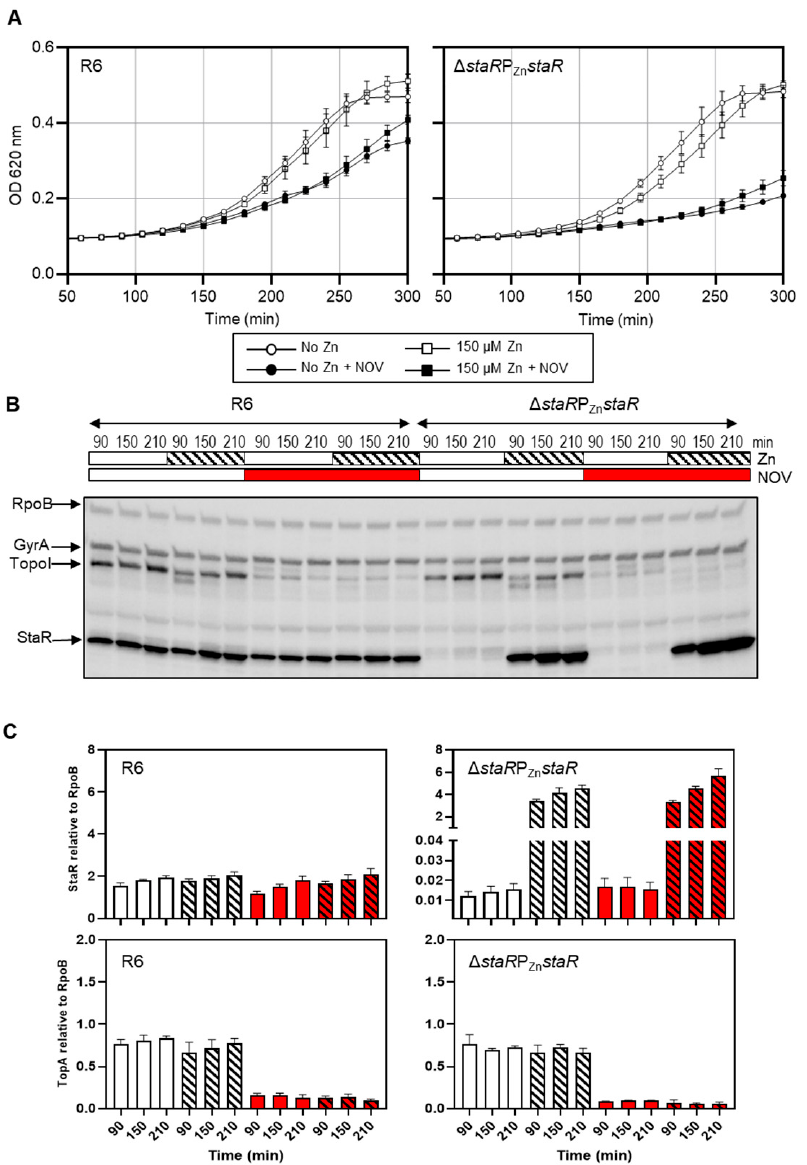
Figure 2. Effect of StaR expression under the control of P Zn promoter. Wild-type R6 and ∆ staR P Zn staR strains were used. Strain ∆ staR P Zn staR carries a deletion of staR and a single ectopic copy of staR under the control of P Zn promoter. ( A ) Expression of StaR under the control of P Zn impairs growth under NOV treatment. Strains were grown to OD 620 nm = 0.3 in medium without ZnSO 4 , diluted 200-fold in medium without (empty symbols) or with (black symbols) NOV (0.5 × MIC) together with 150 µ M ZnSO 4 (squares) or without ZnSO 4 (circles) and cultures were grown in a TECAN Infinite 200 PRO reader. ( B ) Western blot assays of one of the three replicates using antibodies against GyrA (1:2000), TopoI (1:500), StaR (1:1000) and RpoB (1:2000) as internal control. Samples from the cultures described in ( A ) were taken at the indicated time points and processed as described in the Materials and Methods section. ( C ) Levels of StaR and TopoI proteins in the absence (empty bars) or in the presence (striped bars) of ZnSO 4 , and in the absence (white bars) or in the presence (red bars) of NOV, as quantified from Western blots. Protein levels relative to RpoB are shown. Data presented are the average of three independent replicates ±